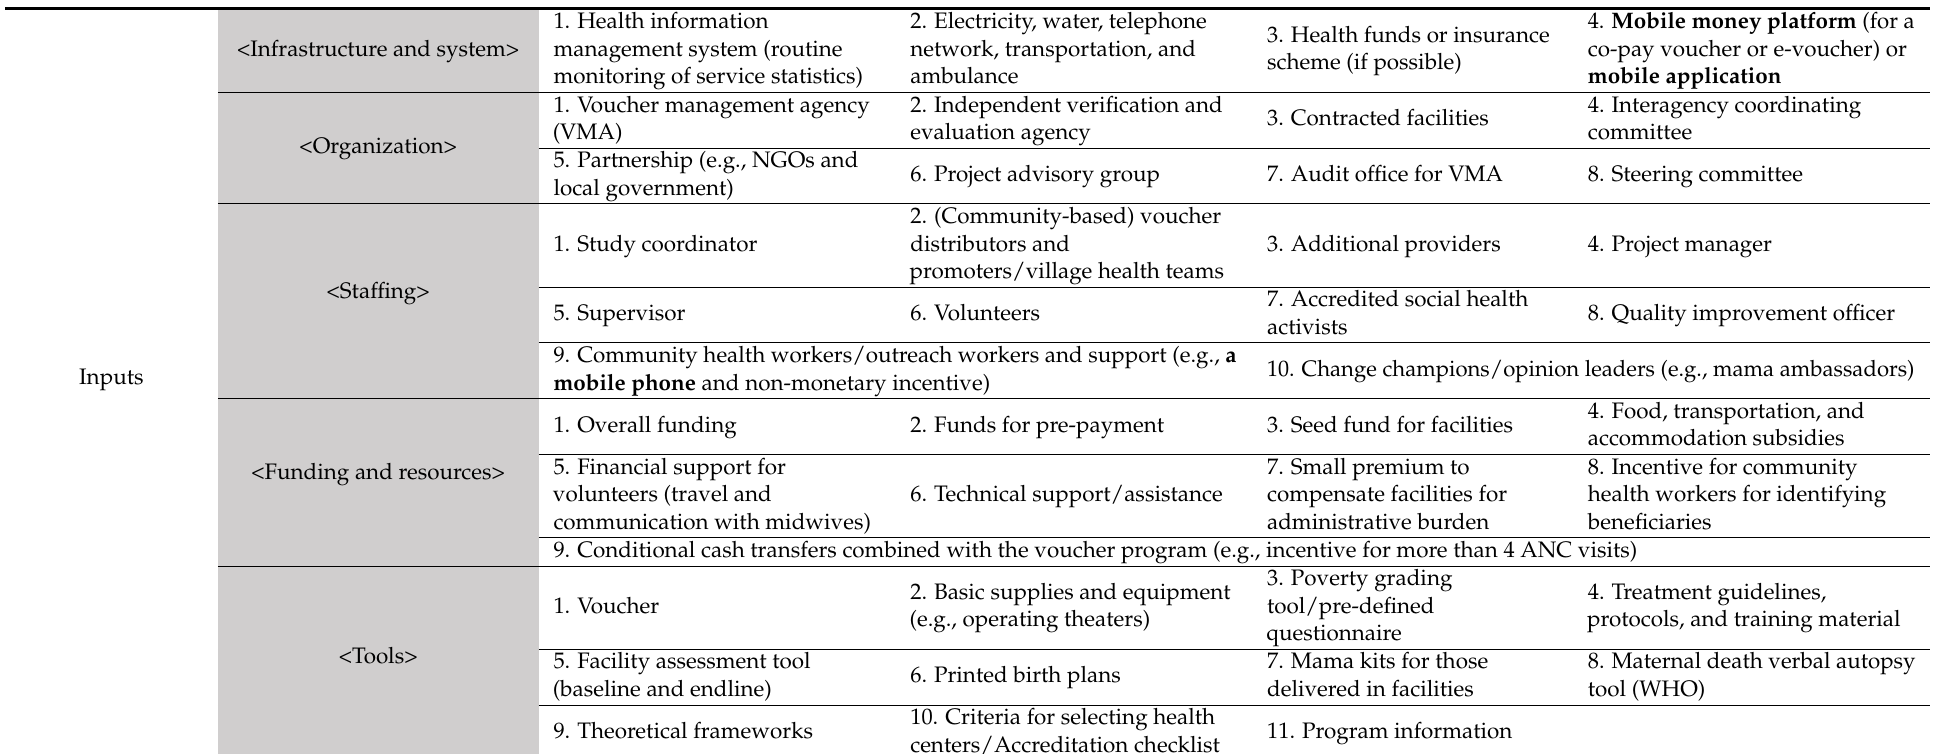
Table 3. Logic model for maternal health services or products via e-voucher